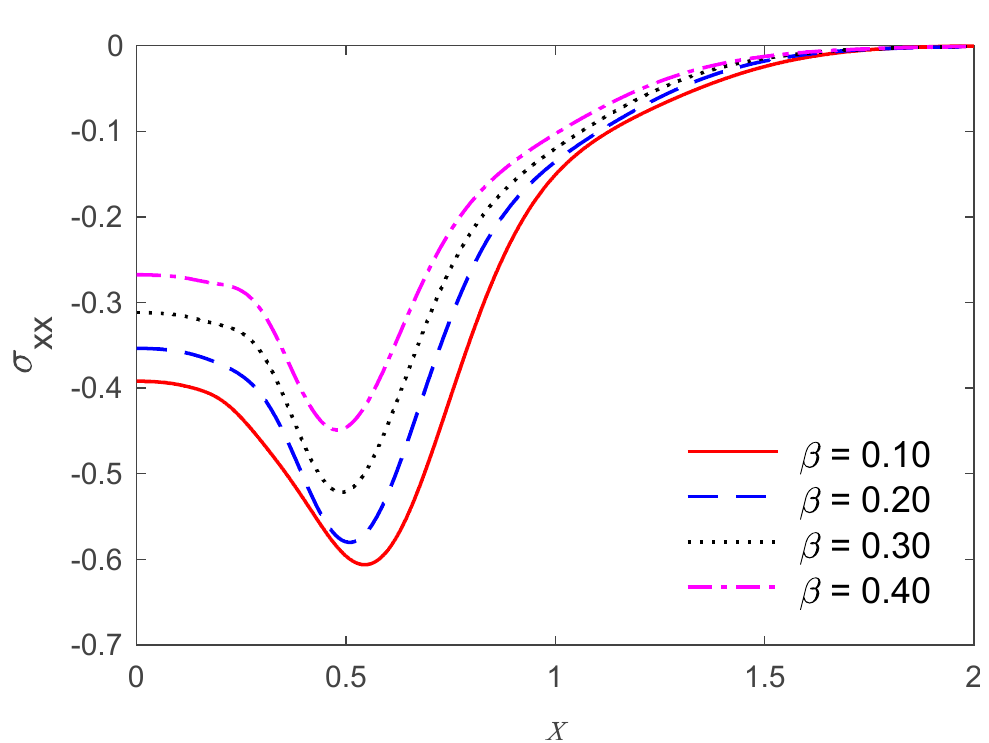
Figure 12. The effects of porosity on the solid stress variations.